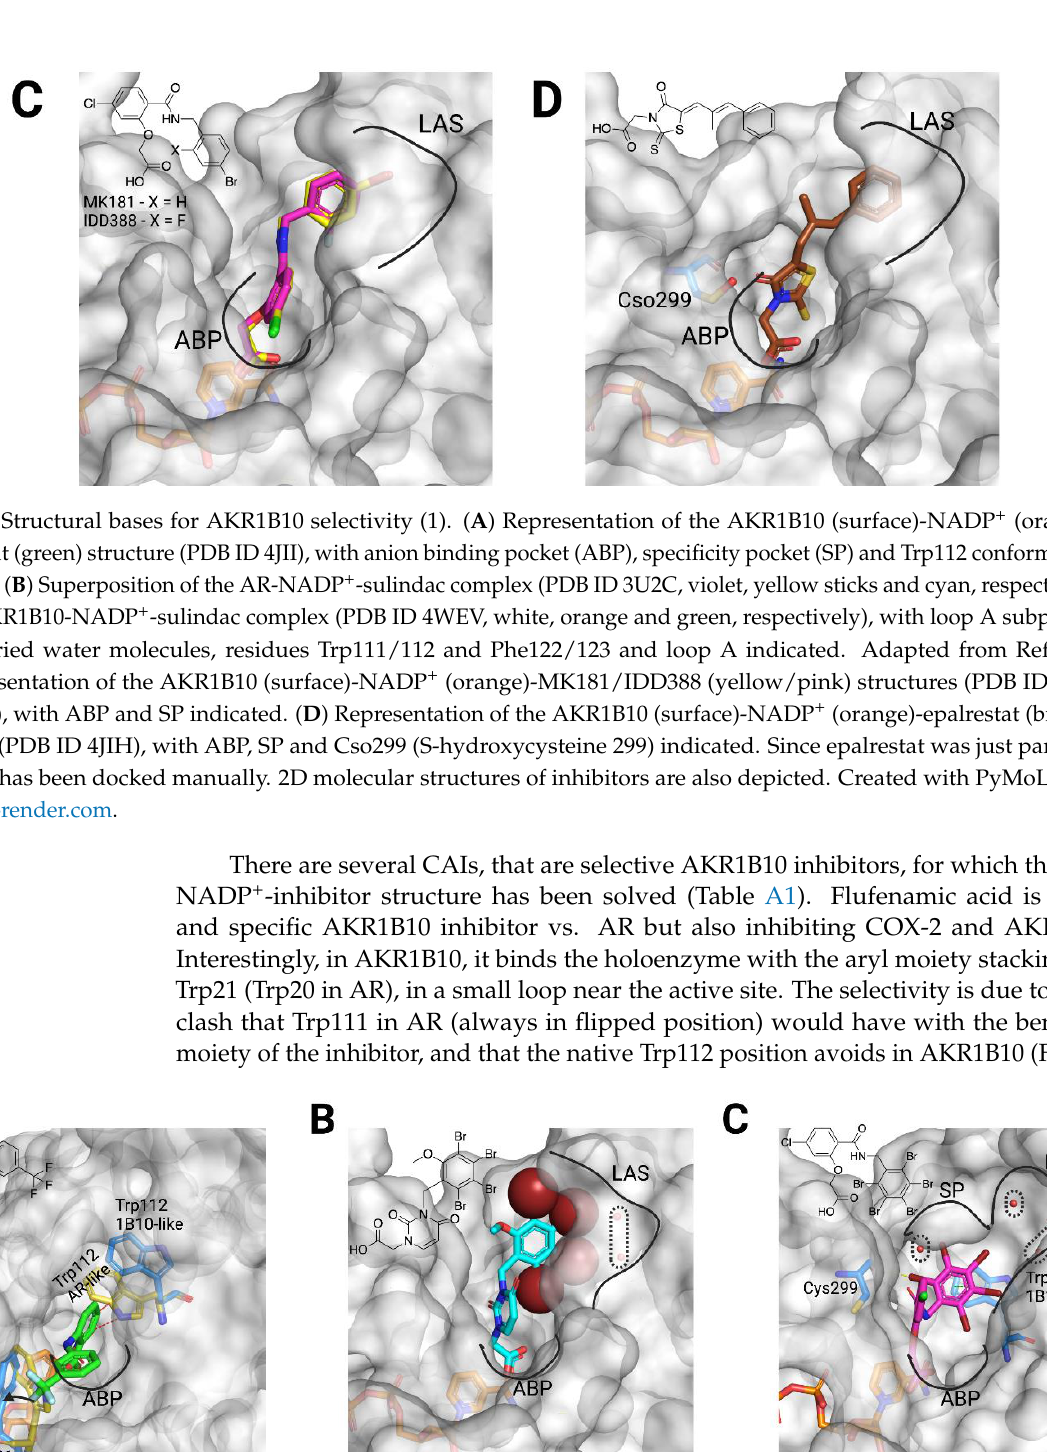
Figure 5. Structural bases for AKR1B10 selectivity (2). ( A ) Representation of the AKR1B10 (surface and blue)-NADP + (or- ange)-flufenamic acid (green) structure (PDB ID 4I5X), with ABP, Trp21 and Trp112 conformations indicated. The last two are compared with the equivalent in the AKR1B10 holoenzyme structure (gold, PDB ID 4GQG). Short contacts between the inhibitor and Trp112 in AR-like conformation (in the holoenzyme structure) indicated with red dashed lines. ( B ) Rep- resentation of the AKR1B10 (surface)-NADP + (orange)-JF0049 (cyan, Br atoms as spheres) structure (PDB ID 4XZL), with ABP and loop A subpocket (LAS) and its buried water molecules indicated. ( C ) Representation of the AKR1B10 (surface and blue)-NADP + (orange)-MK204 (pink) structure (PDB ID 5LIY), with ABP, SP, Trp112 conformation, Cys299 and buried water molecules in SP and LAS indicated. ( D ) Representation of the AKR1B10 (surface and blue)-NADP + (orange)-JF0064 (light pink) structure (PDB ID 4ICC), with ABP and loop B subpocket (LBS) indicated. The protein surface is compared to the equivalent in the AKR1B10 holoenzyme structure (blue surface, PDB ID 4GQG), showcasing the LBS opening induced by inhibitor binding. ( E ) Representation of the AKR1B10 (surface and blue)-NADP + (orange)-CAPE/2-methoxy-CAPE (khaki/green) structure (PDB ID 4GQ0/manually docked), with ABP, LAS, Trp112 conformation, Tyr49 and His111 indi- cated. Trp112 conformation is compared with the equivalent in the AKR1B10 holoenzyme structure (gold, PDB ID 4GQG). Short contacts between the 2-methoxy-CAPE and Trp112 in AR-like conformation (in the holoenzyme structure) indicated with red dashed lines. ( F ) Representation of the AKR1B10 (surface and orange)-NADP + (orange)-Androst-4-ene- 3β,6α - diol ( 3a , yellow) structure (PDB ID 5Y7N), with ABP and base of loop A subpocket (BLAS, with its lining residues) indi- cated. The protein surface is compared to the equivalent in the AKR1B10 holoenzyme structure (blue surface and sticks, PDB ID 4GQG), showcasing the BLAS opening induced by inhibitor binding and involving a conformational change of Phe123. The last is stabilized in the current structure by a stacking contact with Leu302, indicated by a green dashed line. 2D molecular structures of inhibitors are also depicted. Created with PyMoL 2.3.0. and in biorender.com. The other two selective CAIs solved in complex with AKR1B10 holoenzyme, JF0049 and MK204 (Figures 5B,C), have in common polybrominated aryl moieties that are too bulky to fit within the SP of AR [50,51]. Nevertheless, they interact differently with AKR1B10. The aryl moiety of JF0049 is having a tight fit with the LAS, and we also ob- served an enthalpic signature by isothermal titration calorimetry upon its binding, con- sistent with the displacement of the water molecule trapped in the LAS in the holoenzyme structure. Indeed, the LAS presents just one or two ordered water molecules, but it is likely that other disordered and mobile water molecules are present. While their release should not contribute significantly to a large entropy gain, the new hydrogen bonds they will form with other water molecules in the bulk phase may add a significant enthalpic benefit [50].